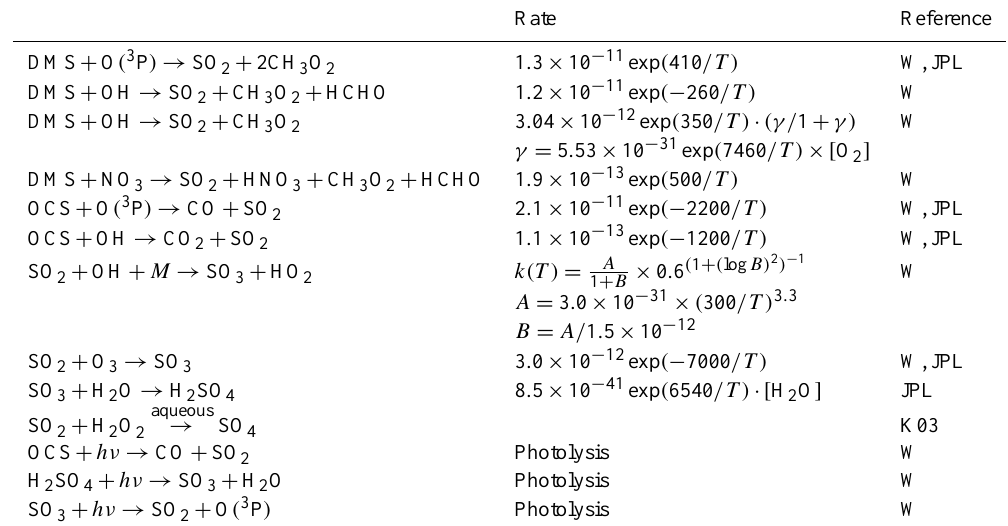
Table 1. Additional sulfur chemistry reactions and rates within UM-UKCA, W = Weisenstein et al. (1997), JPL = Sander et al. (2006), K03 = Kreidenweis et al.